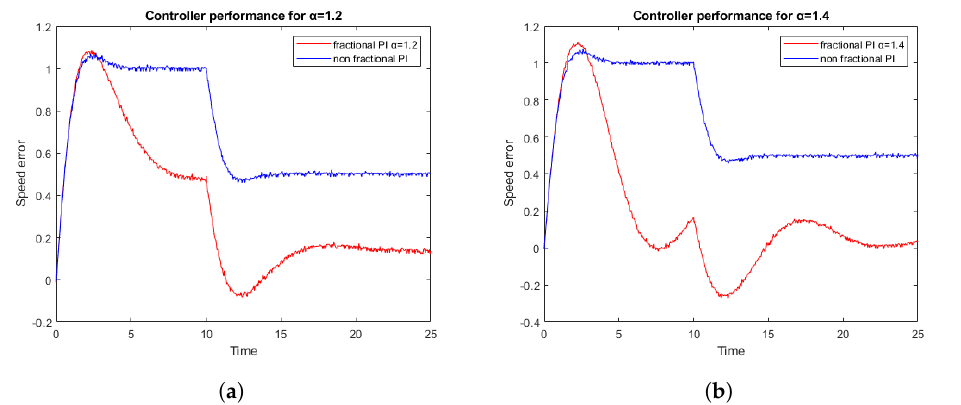
Figure 9. Tracking errors for a fixed reference of 2.5 m with K p = 1.2; K i = 1. ( a ) For a PI versus PI 1.2 ; and ( b ) For a PI versus PI 1.4